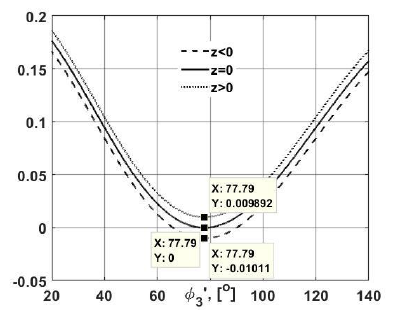
Fig. 7. The trajectory of point C of the synthesized mechanism at the stage of operation